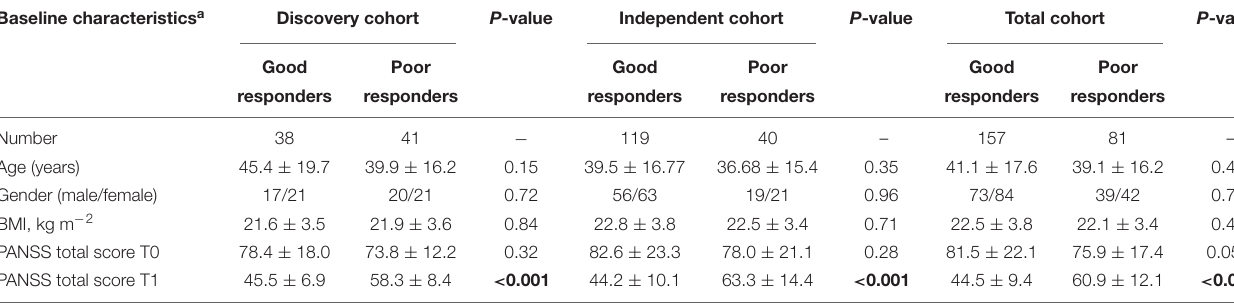
TABLE 1 | Demographic and clinical details of patients suffering from schizophrenia in three